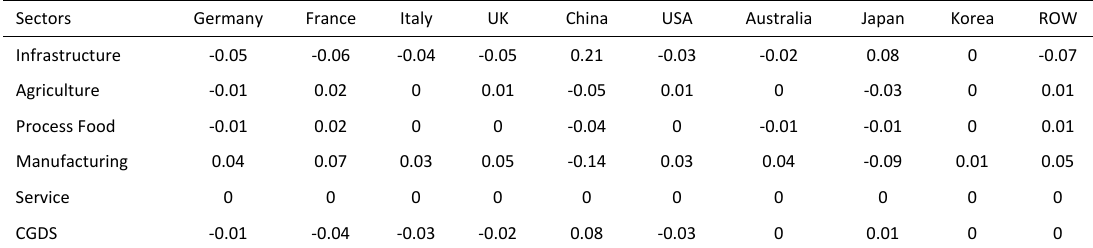
Table 7: Change in output volume by sector (%)